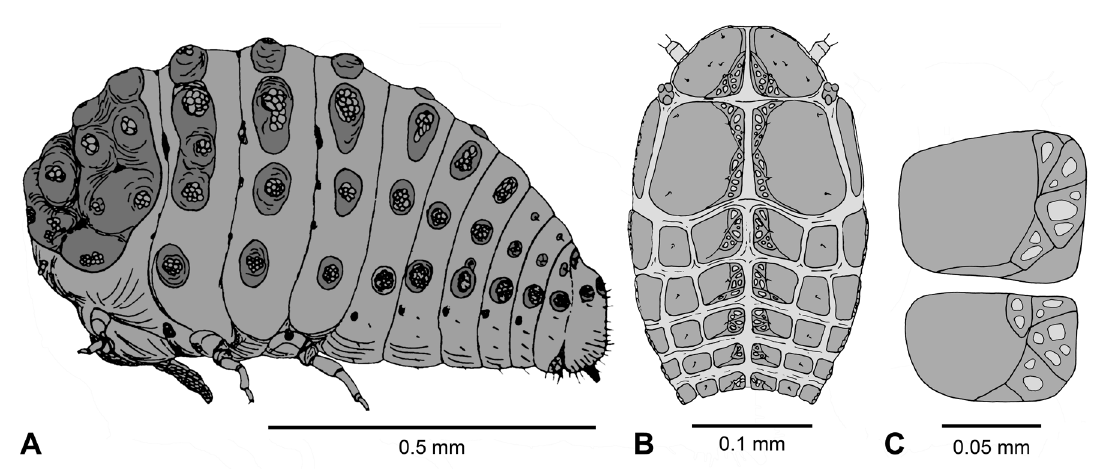
Fig. 47. Adelges (Dreyfusia) piceae (Ratzeburg, 1843). A . Adult sistens (after Börner 1908, redrawn and modified). B – C . Hibernating first instar nymph (neosistens). B . Habitus, showing arrangement of sclerites and wax gland pits (after Schneider-Orelli 1947, modified and redrawn). C . Spinal sclerites of meso- and metathorax, left side (after Pschorn-Walcher & Zwölfer 1958, modified and